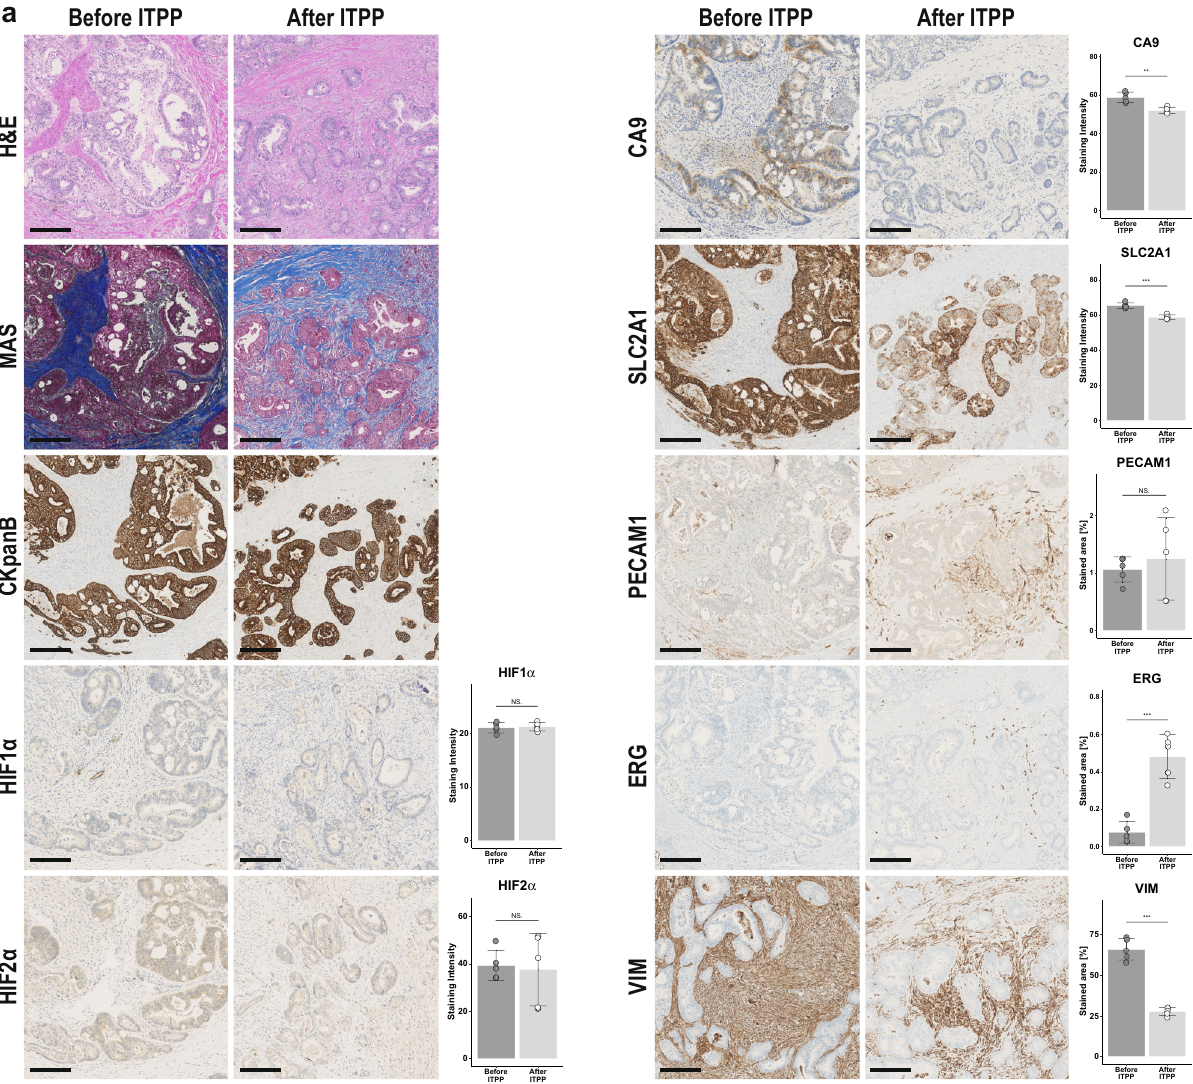
Fig. 4 Tissue-based hypoxia response markers of one exemplary patient. a Histological images taken at 20x magni fi cation of the sample taken before ITPP treatment (left hemi-hepatectomy) compared to the sample obtained after ITPP (microwave ablation). Note the decreased expression of hypoxia- mediated genes such as CA9 and SLC2A1 after ITPP treatment and signs of increased vessel maturity by increased EGR expression. Scale bare: 200 μ m. N = 1 patient. Histological quanti fi cations are shown as boxplots displaying mean values ± standard deviation and overlaid single measurements. Statistical differences derived from two-sided students t -test with no adjustment for multiple comparisons. ** p < 0.01, *** p ≤ 0.001, NS. = No signi fi cant